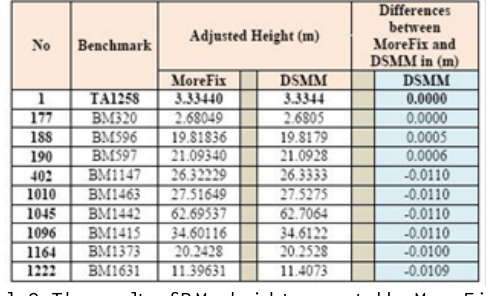
Table 2: The results of BMs height computed by MoreFix vs Jupem results – Datum Pulau Lakei